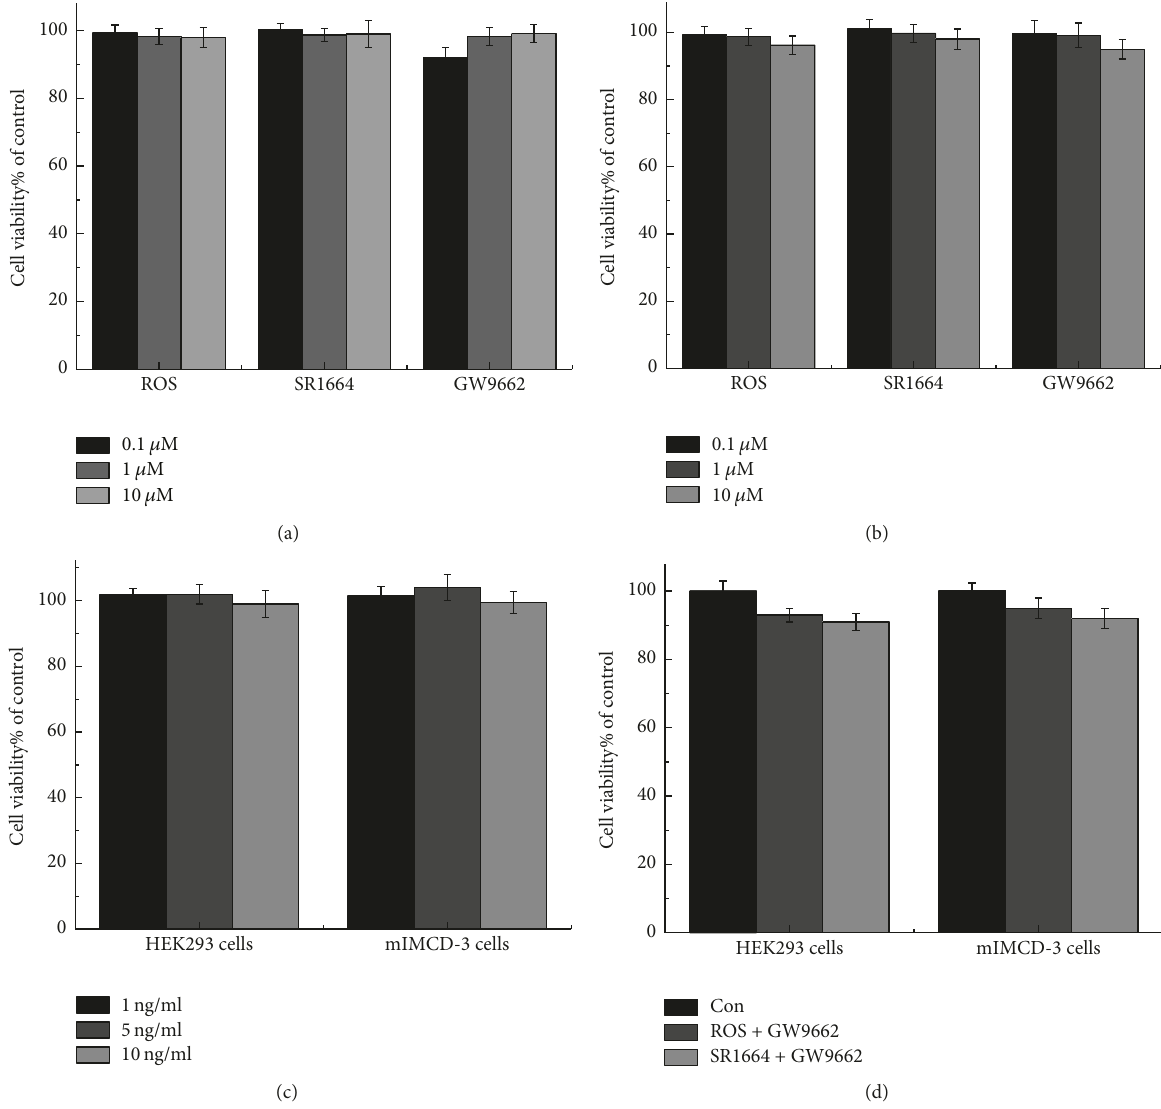
Figure 1: In vitro experiments on the cytotoxic effects of ROS, GW9662, SR1664, and TNF 𝛼 in HEK293 and mIMCD-3 cells. (a) The effects of ROS, SR1664, and GW9662 (0.1, 1, and 10 𝜇 M) in HEK293 cells. (b) The effects of ROS, SR1664, and GW9662 (0.1, 1, and 10 𝜇 M) in mIMCD-3 cells. (c) The effects of TNF 𝛼 (1, 5, and 10 ng/ml) in HEK293 and mIMCD-3 cells. (d) Coincubation with ROS (10 𝜇 M) and GW9662 (5 𝜇 M) and SR1664 (10 𝜇 M) and GW9662 (5 𝜇 M). The results show that the concentrations that we used in the experiments have no significant cytotoxic effects. Results are shown as mean ± s.e.m., 𝑛 = 3 .